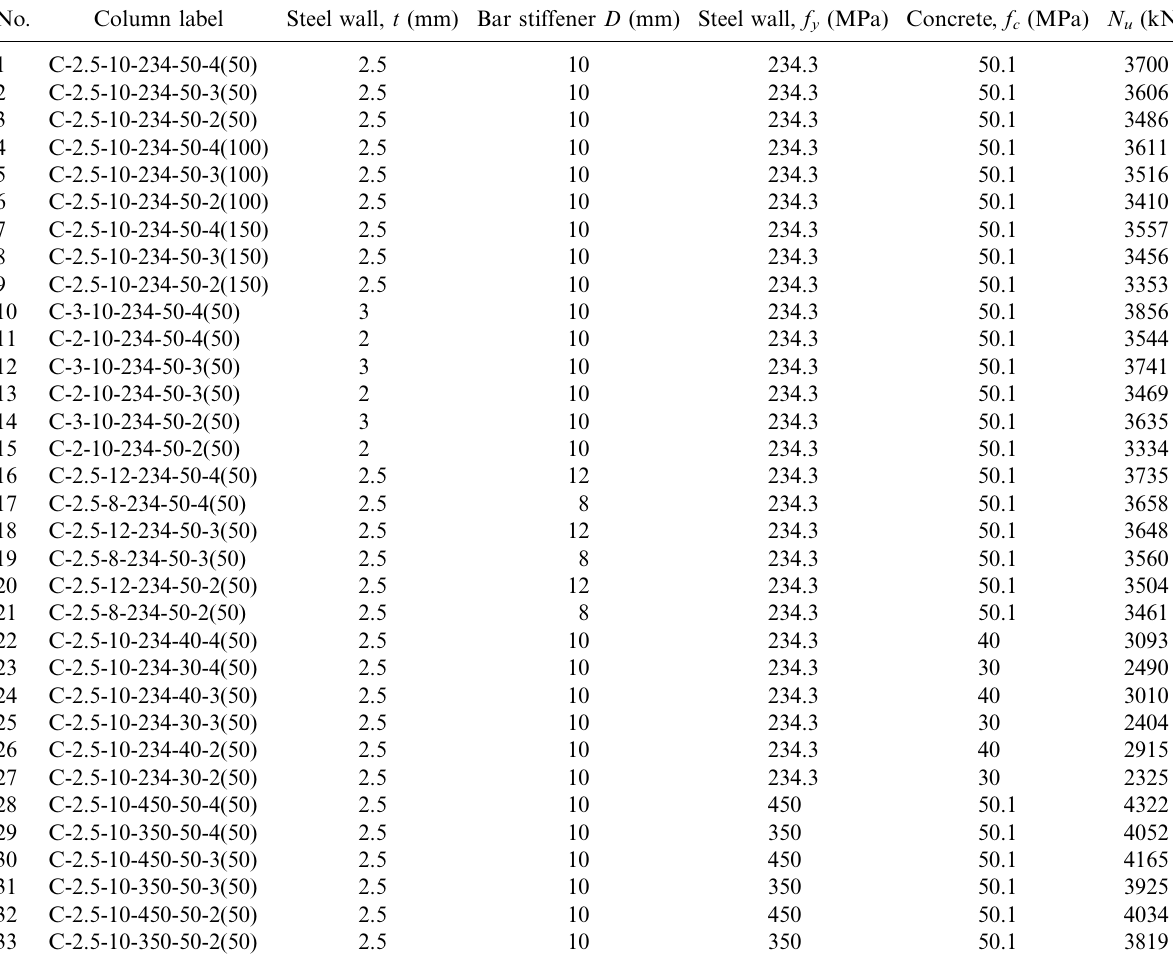
Table 1. Features and obtained ultimate axial load capacities ( N u ) of the columns No. Column